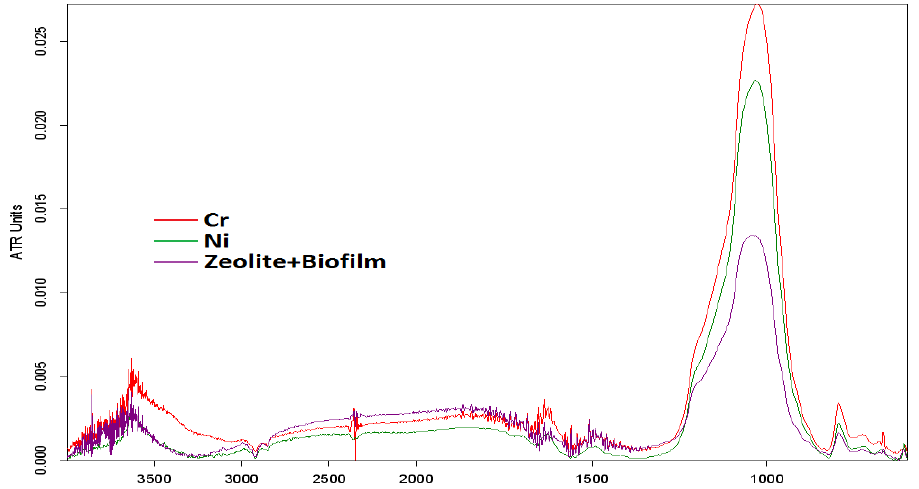
Figure 5. Fourier transform infrared spectra of zeolite/biofilm before and after metal